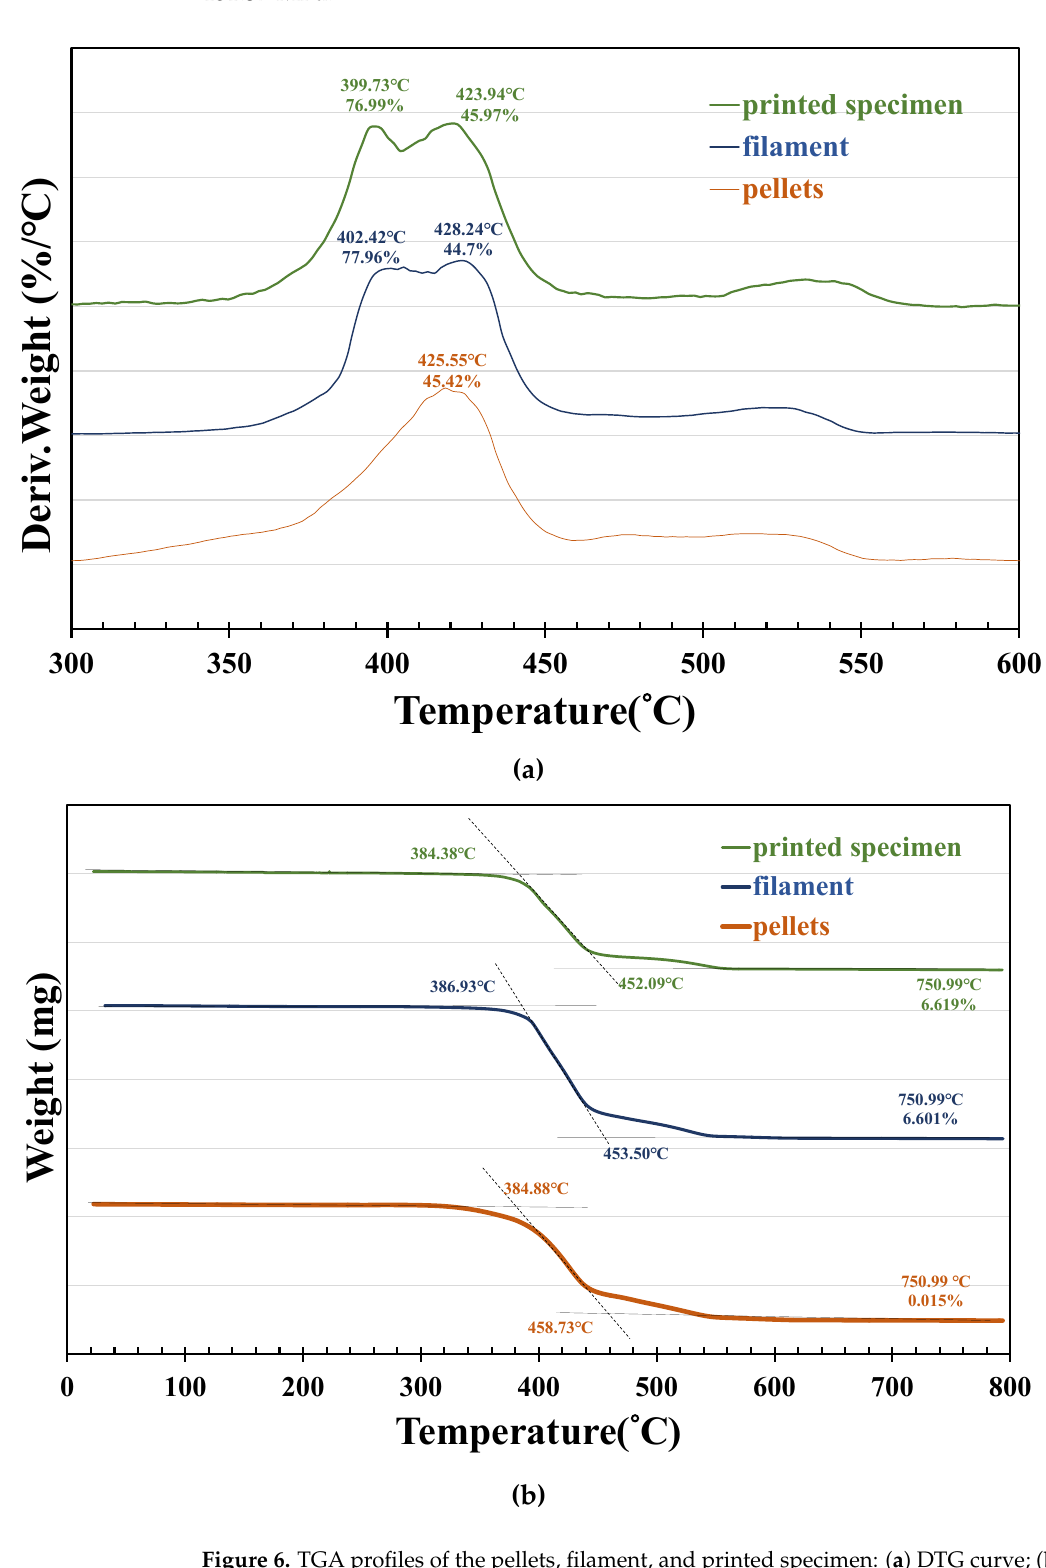
Figure 6. TGA profiles of the pellets, filament, and printed specimen: ( a ) DTG curve; ( b ) TGA curve.